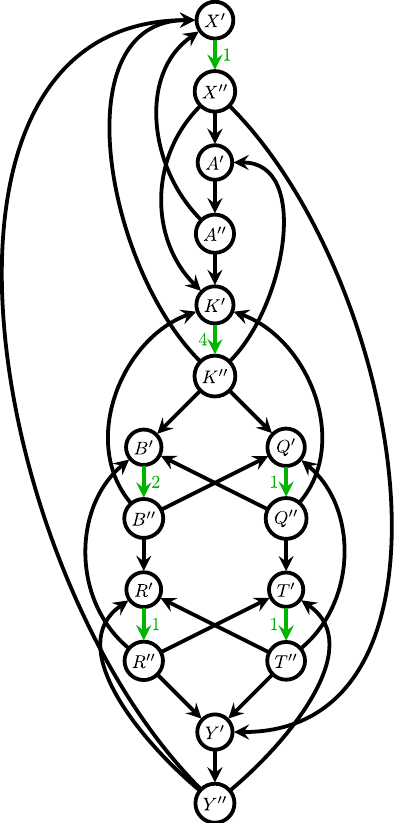
Figure 1: The fl ow network (cid:4) corresponding to the directed acyclic graph in Figure 2. Edges with fi nite capacities are colored green, with the numbers next to the edges representing capacities. All black edges have in fi nite